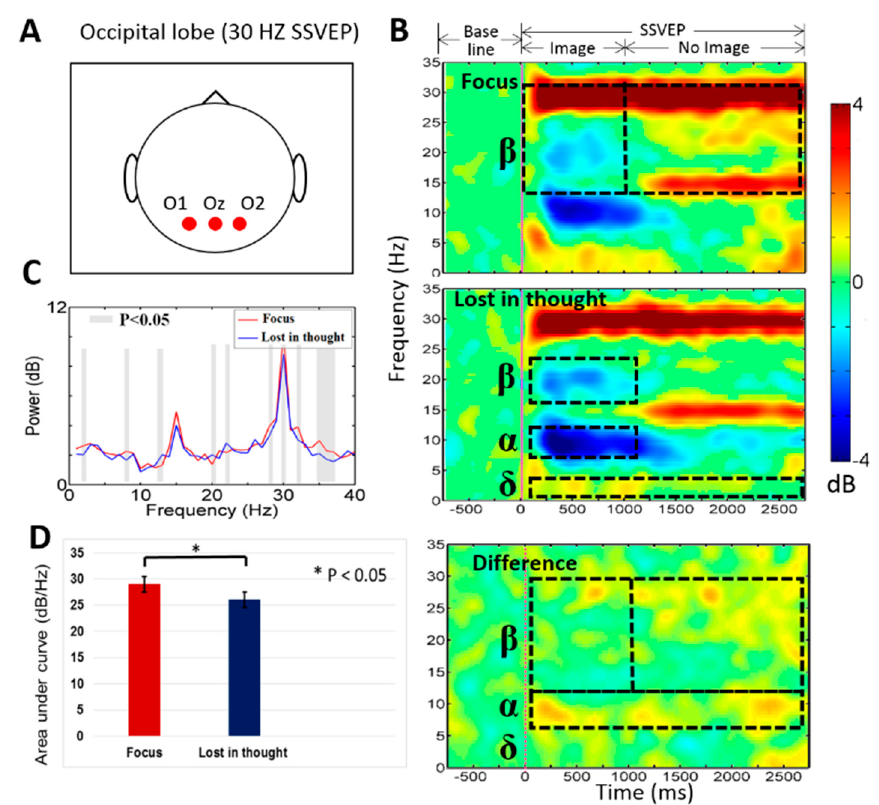
Figure 7. ( A ) Shows O1, Oz, O2 electrodes positions in occipital lobe. ( B ) The ERSP was investigated in mental focus and lost-in-thought states at 30 Hz SSVEP. The pink vertical line show the stimulus onset. Statistically significant at p < 0.05. Color bar indicate the scale of significant ERSP in decibel (dB). ( C ) The PSD for the mental focus state (red line) and lost-in-thought state (blue line). The grey areas represent statistically pairwise significant di ff erence ( p < 0.05) in t -tests between the mental focus and lost-in-thought states. ( D ) The AUC was measured in mental focus and lost-in-thought states (* p < 0.05).